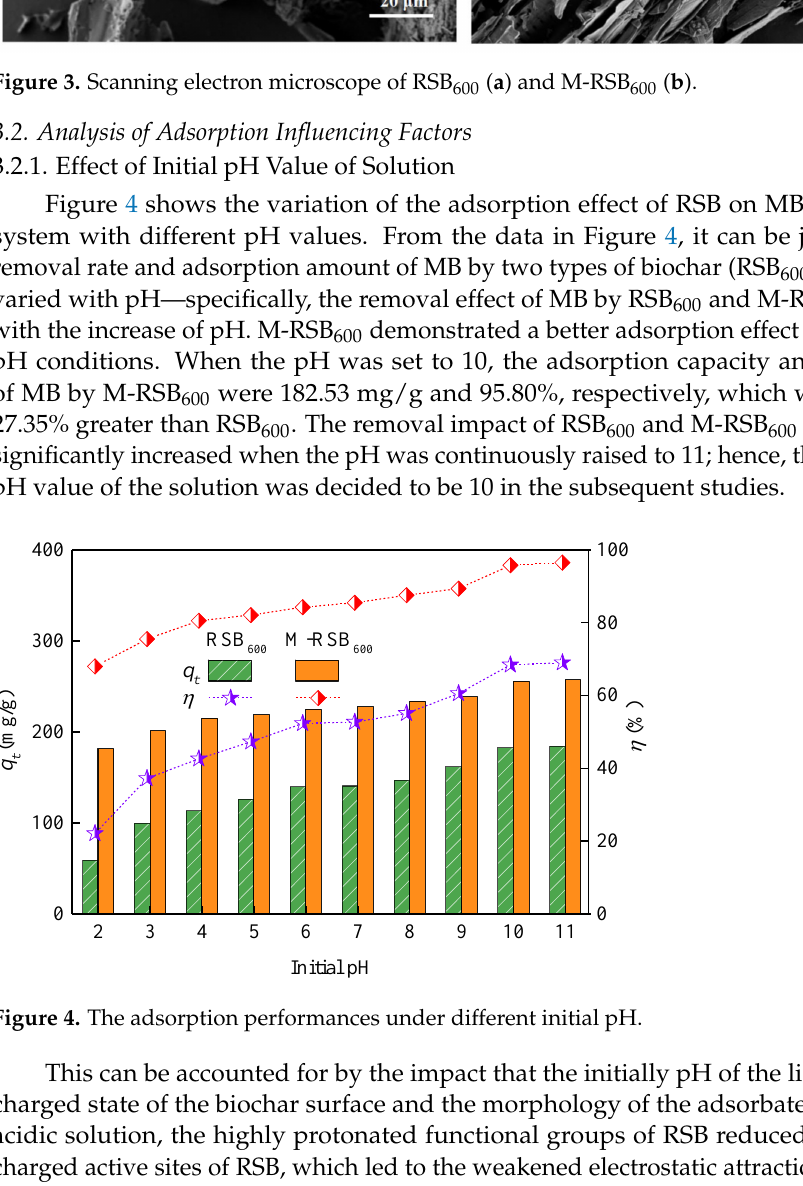
Figure 6. The adsorption performance under different RSB dosages.